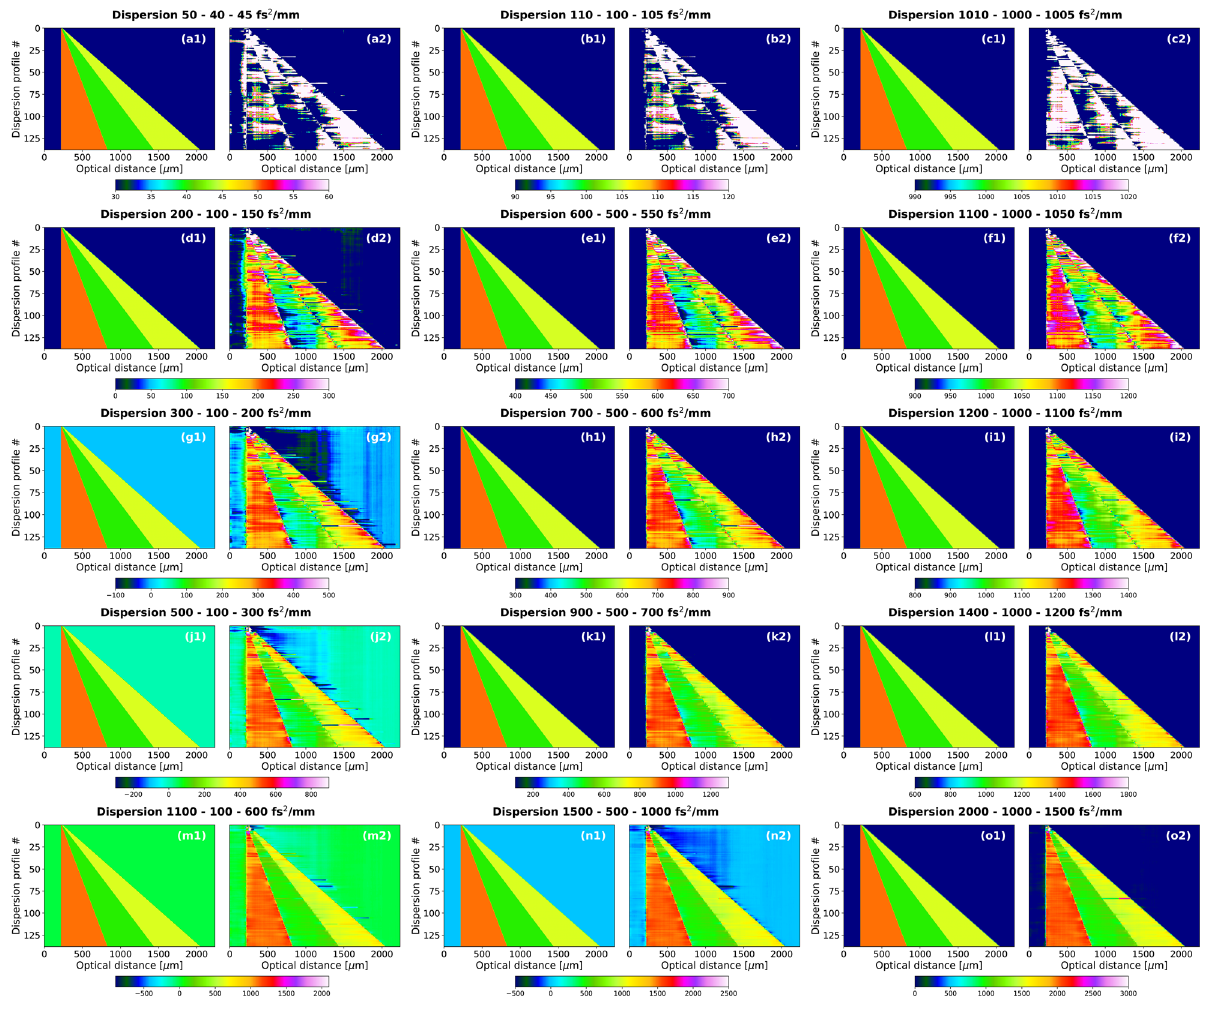
Figure 5. ( a 1– o 1) Ground truth dispersion maps, ( a 2– o 2) Dispersion maps predicted using the 30 dB neural network. The titles of each pair of images state the GVD values of the layers of the object: the values increase from left to right in each row and the difference of GVD values within the object increases from top to bottom. The greater the variability of GVD values within the object, the better the